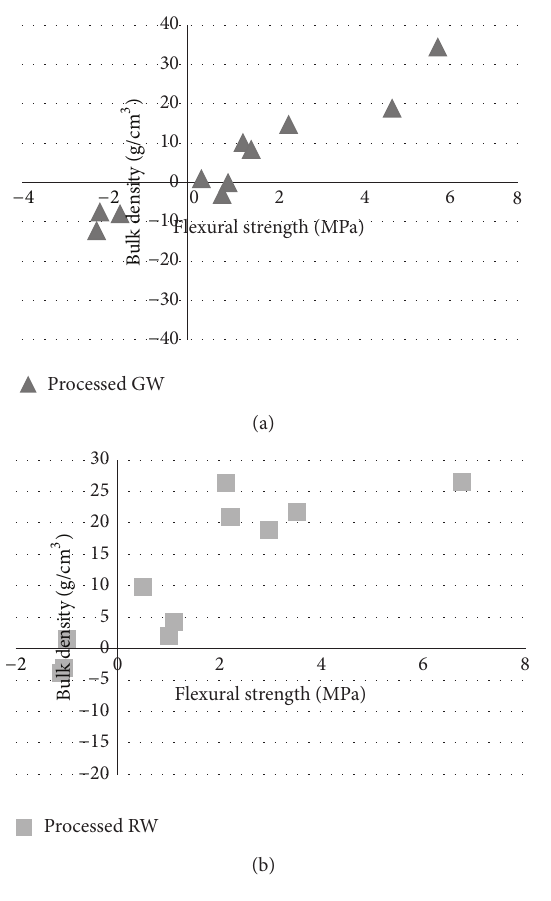
Figure 10: Relation between density and mechanical flexural strength.